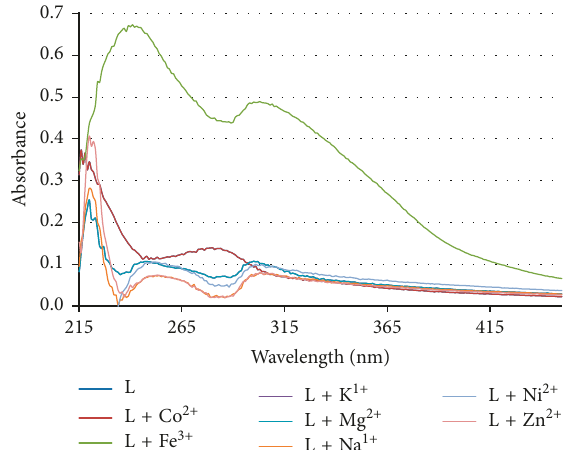
Figure 2: Absorption spectra of the derivative L (ligand) 5 M) with different essential metals ions (2.6 (2.6 10 × −